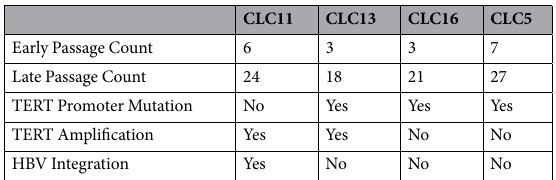
Table 2. Patients in the HCC